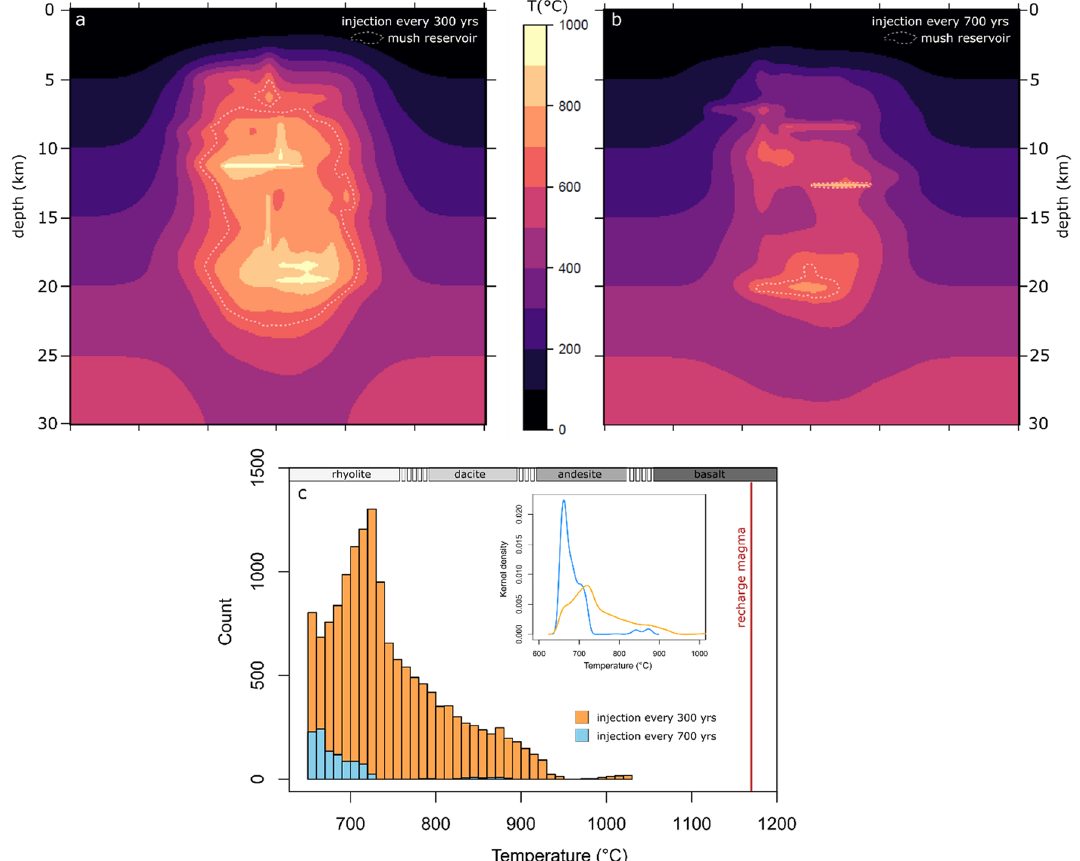
Figure 6. Relationship of compositional diversity and thermal state of igneous plumbing systems. ( a ) Two- dimensional temperature (°C) cross section through a crustal magmatic system built by injection of dikes and sills at a pulse rate of one injection every 300 years for 100,000 years. Dikes and sills were randomly injected over the depth range of 4 to 20 km with basaltic composition at liquidus temperature of 1170 °C. ( b ) Crustal plumbing system built by the same parameters as in ( a ) but at lower magma injection rate of one pulse every 700 years, resulting in less voluminous mush bodies and smaller temperature range of magma in the plumbing system. ( c ) Histogram of temperatures for scenario ( a ) is shown in orange and ( b ) in blue. The recharge magma composition is indicated by a vertical red line and approximate temperature ranges of magma compositions are shown. Inset shows the kernel density distribution of the